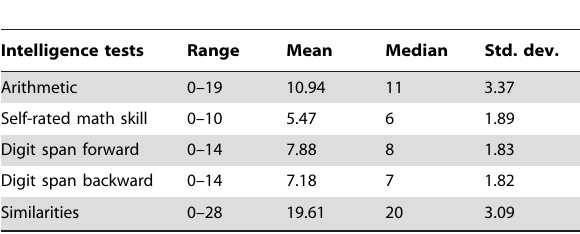
Table 1. Descriptive statistics of the WAIS-R subscales and self-rated mathematical